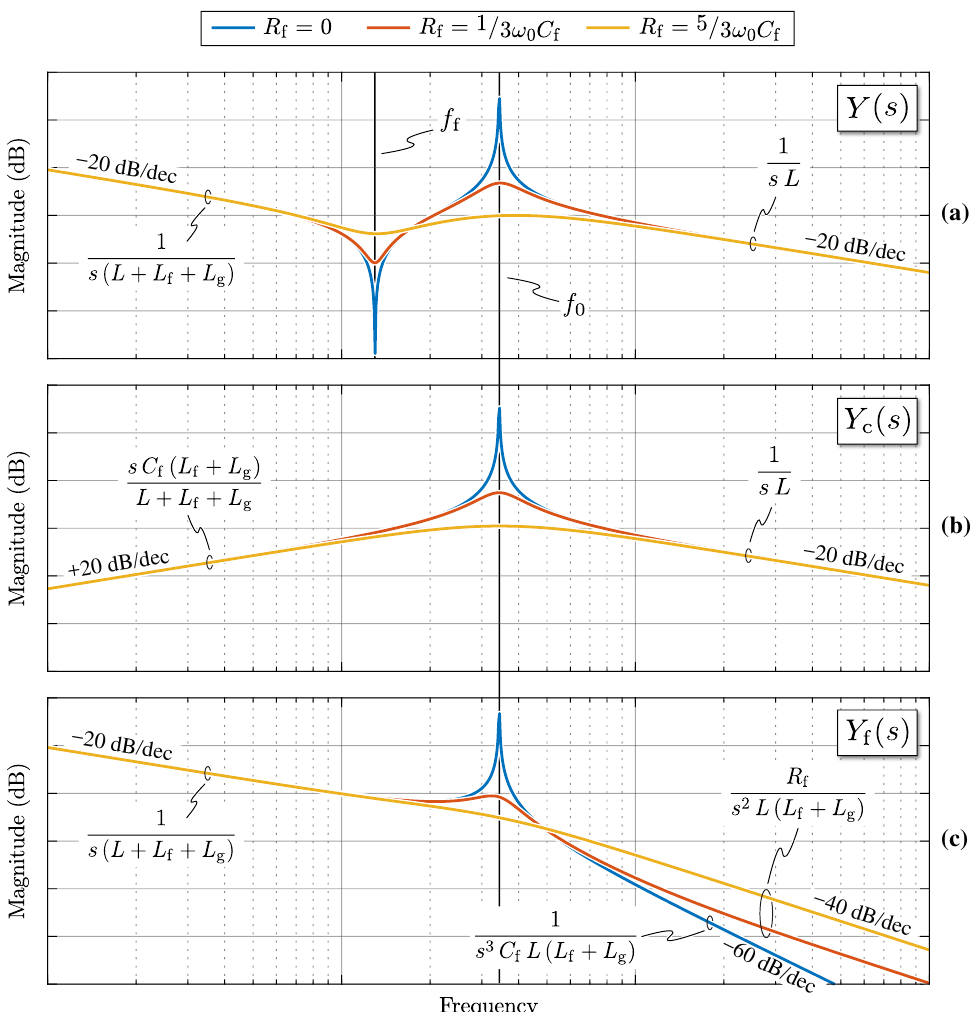
Figure 4. Qualitative representation in the logarithmic scale of the magnitude of Y ( s ) ( a ), Y c ( s ) ( b ) and Y f ( s ) ( c ), for different values of damping resistance R f . The resonance frequencies f f = ω f /2 π and f 0 = ω 0 /2 π are indicated, while the asymptotic trends of the transfer functions are noted on the